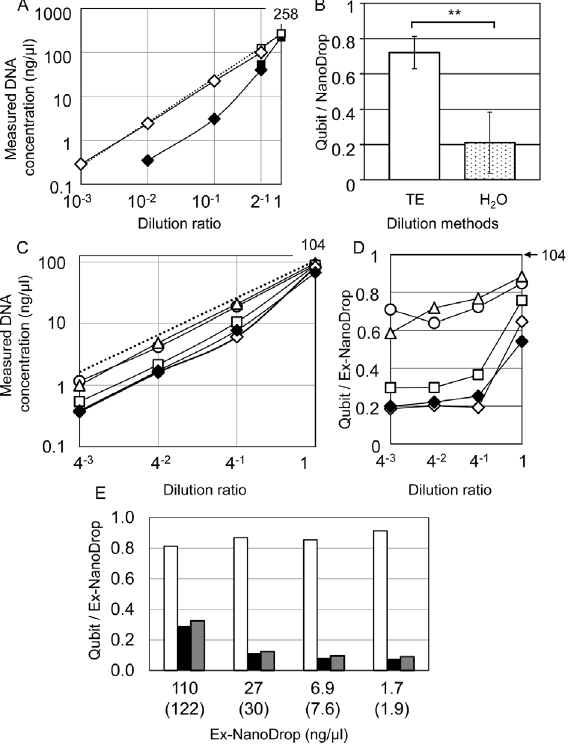
Fig 3. Quantification of Frozen-DNA diluted with various solutions by Qubit. (A) Frozen-R2 DNA was serially diluted with distilled water (black) or TE buffer (white), and the concentration of each diluent was measured by BR-Qubit (square) and HS-Qubit (diamond). (B) Eleven Frozen-DNAs were diluted with distilled water or TE buffer to approximately 20 ng/ μ l, as measured by NanoDrop, and the concentration of each diluent was measured by HS-Qubit. The ratios of the Qubit to NanoDrop values were determined for each diluent. (C, D) Frozen-R1 DNA was serially diluted with distilled water (closed diamonds), 0.01 mM NaCl (open diamonds), 0.1 mM NaCl (squares), 1 mM NaCl (triangles) or 10 mM NaCl (circles). The broken line shows the expected NanoDrop values. The concentration (ng/ μ l) of each original DNA solution, as measured by NanoDrop, is shown at the top right: dilution ratio = 1. (D) The Q/E ratio was determined for each diluent, as shown in Fig 3C. (E) Frozen-R2 DNA was serially diluted with TE buffer (white) or distilled water (black), and a 0.1 volume of 100 mM Tris-HCl/10 mM EDTA was added to the latter diluent (gray). The expected NanoDrop values in parentheses indicate those diluted with distilled water. The detection limits of each measurement are described in Fig